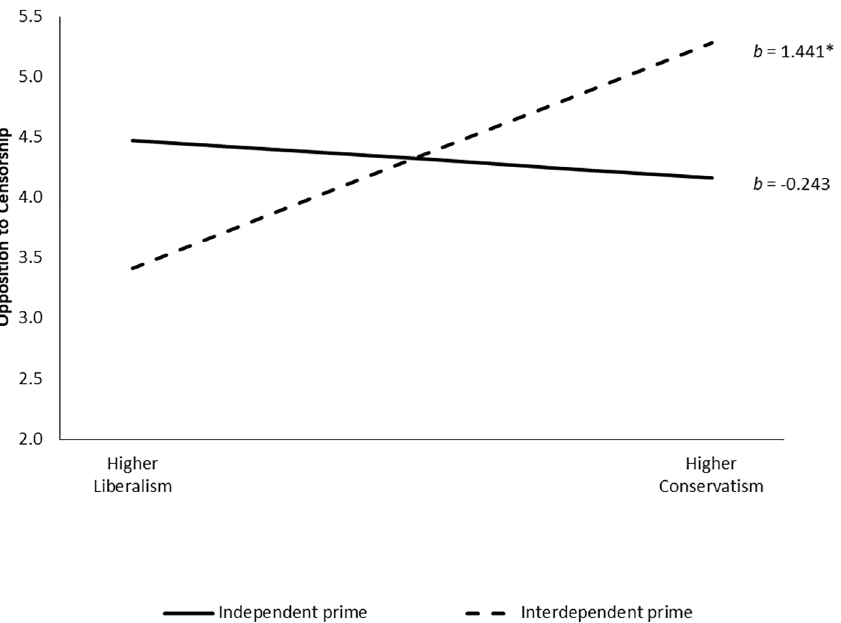
Figure 3. Mean values for participants’ opposition to censorship subscale scores based on experimental condition and mean-centered self-ratings of political orientation (Study